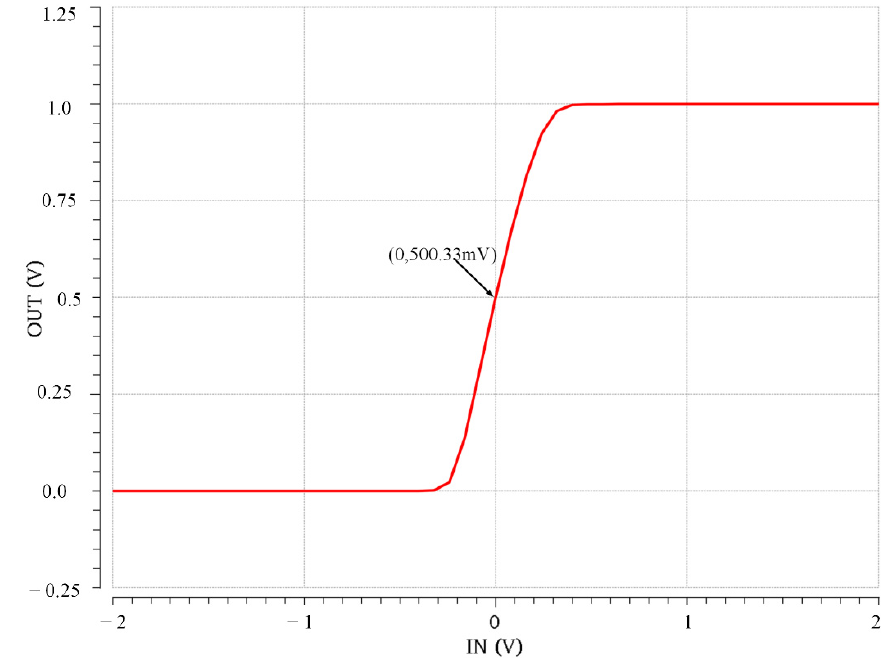
Figure 5. Simulated high-precision sigmoid.